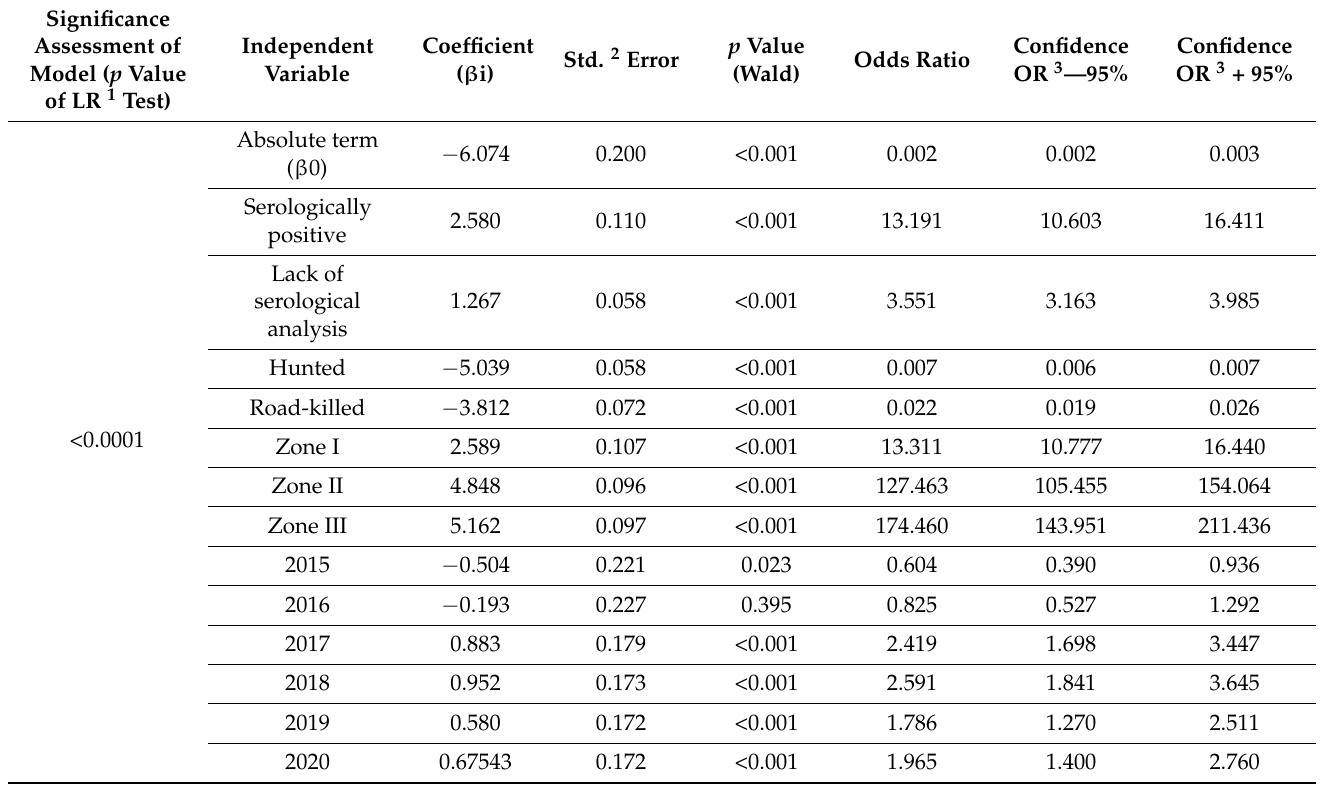
Table 2. Results of logistic regression models—impact of the type of result, animal status, ASF zone, and the year for the final molecular/virus-positive result (reference type of result: molecular/virus- positive; reference animal status: found-dead; reference ASF zone: 0; reference year: